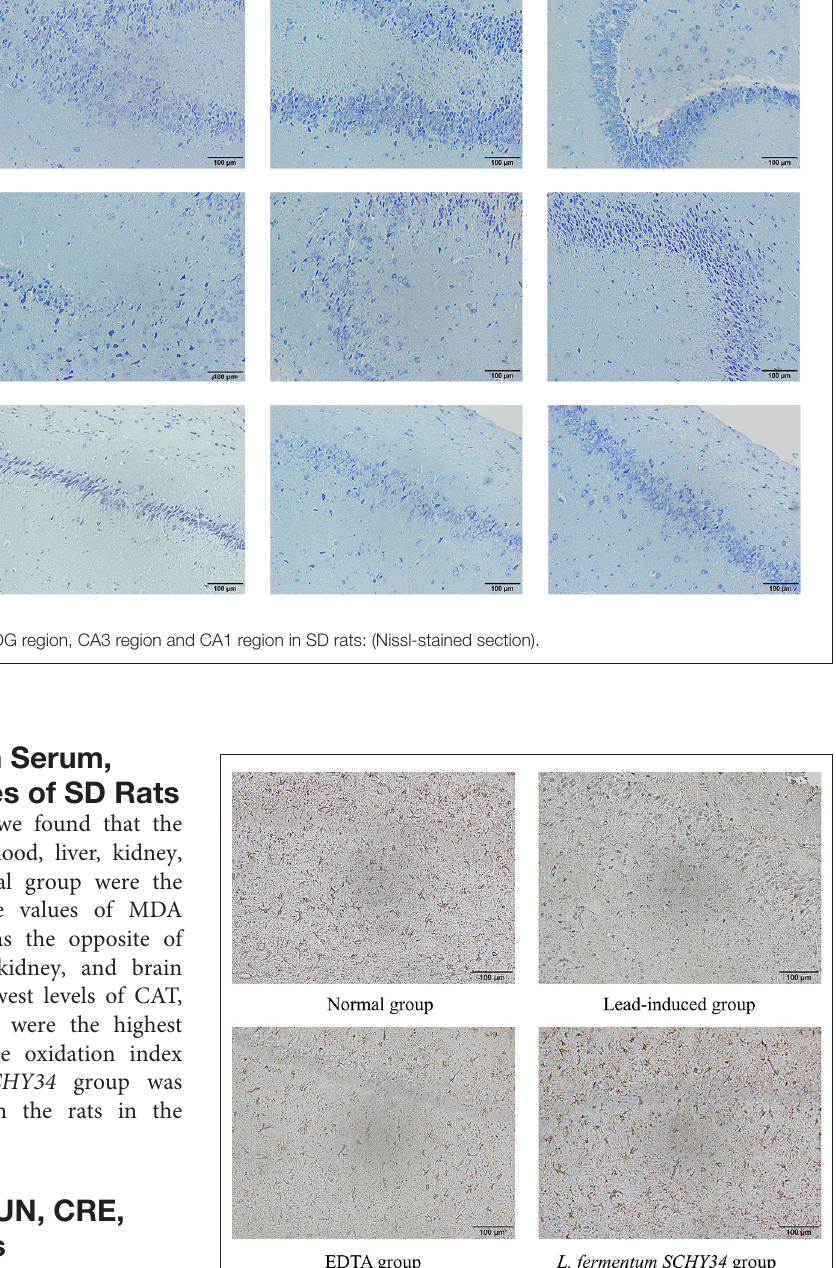
induction group. In addition, the δ -ALAD enzyme activity was the intervention effect of L. fermentum SCHY34 was better than EDTA ( Table 6